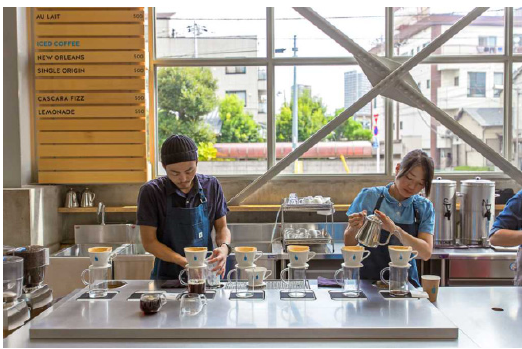
Figure 39. Coffee roasting at Blue Bottle.